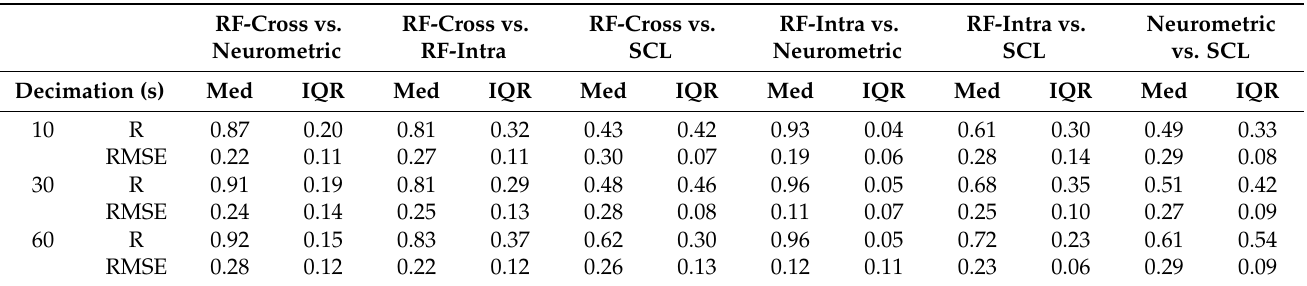
Table 4. Values of Pearson correlation (R) and the distance between curves computed in terms of root mean squared error (RMSE) for the driving experiment. Median (Med) and interquartile range (IQR) have been